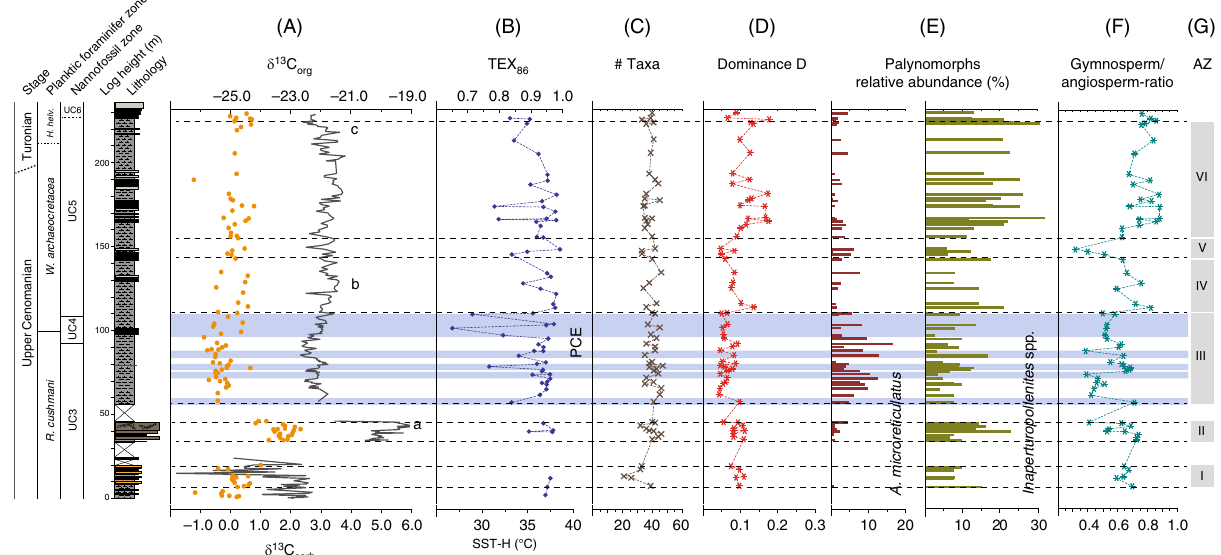
Fig. 3 Terrestrial palynomorph and TEX 86 data across OAE2. Stratigraphic trends in δ 13 C carb , δ 13 C org , TEX 86 -derived sea-surface temperatures (SSTs) and evolution of palyno fl oral diversity and composition across OAE2 at Cassis, S ’ France. Biostratigraphy and lithological log of Cassis section to the left. ( A ) Carbon-isotope stratigraphy based on bulk rock carbonate and organic matter; ( B ) TEX 86 and SST reconstruction based on TEX 86 H calibration; ( C ) species richness; ( D ) dominance index; ( E ) stratigraphic distribution of selected pollen including the Normapolles-type angiosperm pollen Atlantopollis reticulatus and the conifer pollen Inaperturopollenites spp.; ( F ) ratio of gymnosperm versus angiosperm taxa; ( G ) assemblage zones (AZs) based on characteristic spore-pollen associations. PCE = Plenus Cold Event. Blue horizontal bands represent individual SST cooling episodes during the